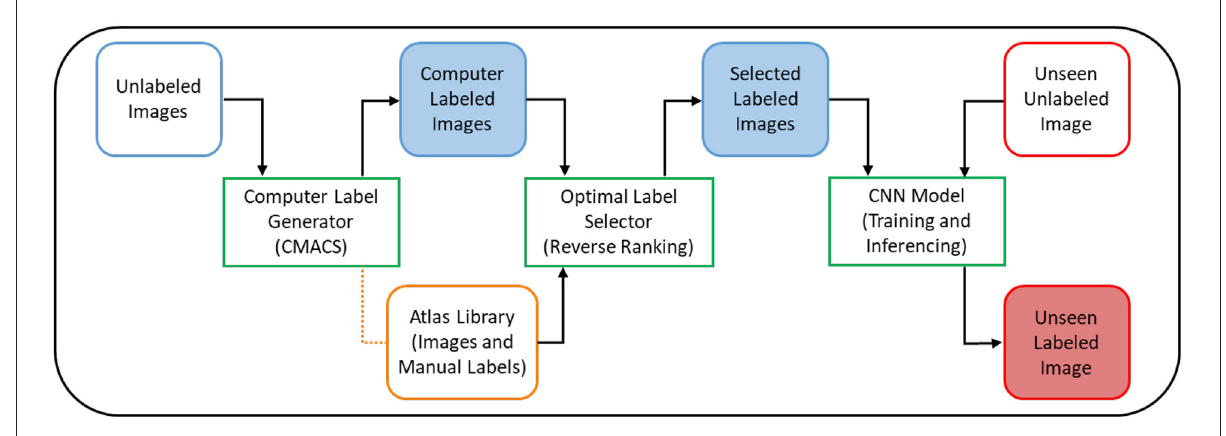
FIGURE1 Flow diagram of the proposed DeepHeartCT framework: A hybrid CMACS and CNN based framework for fully automatic cardiac CTA image labeling, quality assurance, fast and accurate